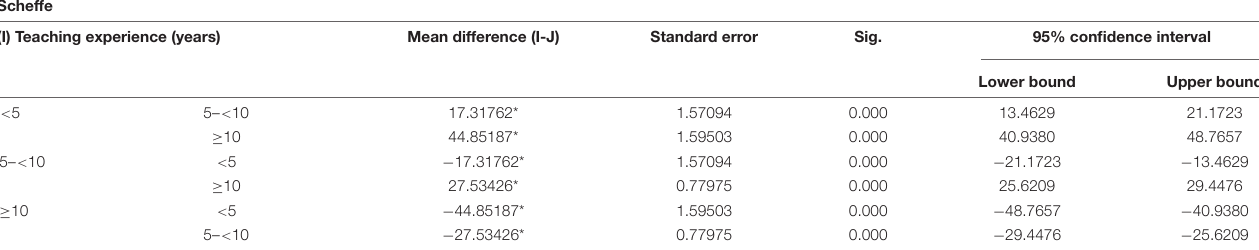
TABLE 6 | Scheffe: Multiple comparison test based on teaching experience. Scheffe (I) Teaching experience (years)